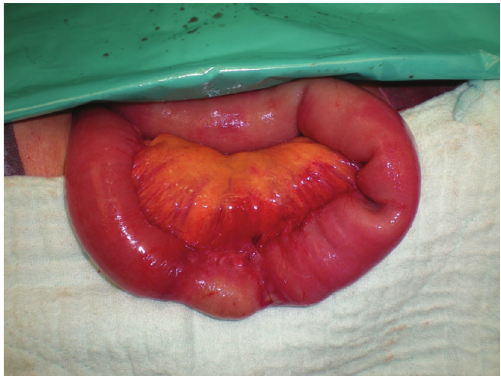
Figure 3: Strangulated small intestinal